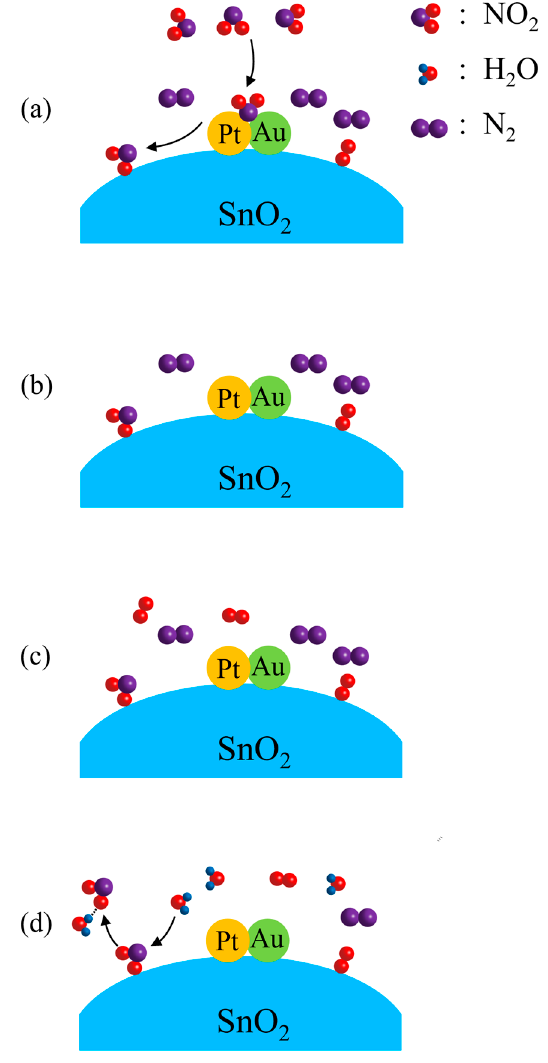
Figure 6. Schematic illustrations for Pt–Au–SnO 2 composite nanoceramics at room temperature in: ( a ) 10 ppm NO 2 –N 2 , where NO 2 molecules are chemisorbed on SnO 2 catalyzed by Pt–Au; ( b ) N 2 , where NO 2 molecules are stably chemisorbed on SnO 2 ; ( c ) 20% O 2 –N 2 , where no more O 2 molecules are chemisorbed on SnO 2 , as those O 2 molecules chemisorbed earlier have remained there; ( d ) air of 50% RH, where NO 2 molecules are desorbed from SnO 2 by the attraction of water molecules in the air.